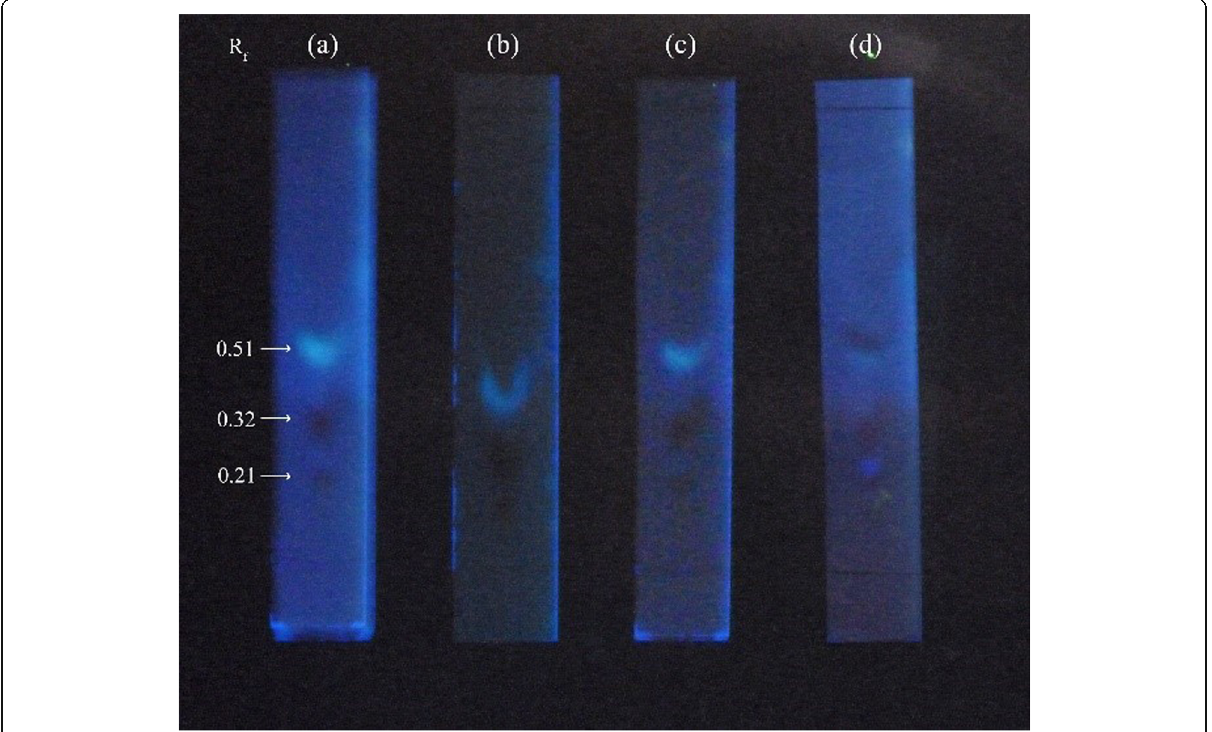
Fig. 1 TLC profiles resulting from the chemically elicited calli ( a ) SA 10 μ M, ( b ) SA 100 μ M, ( c ) MJ 1 mM and ( d ) MJ 10 mM on the 10th